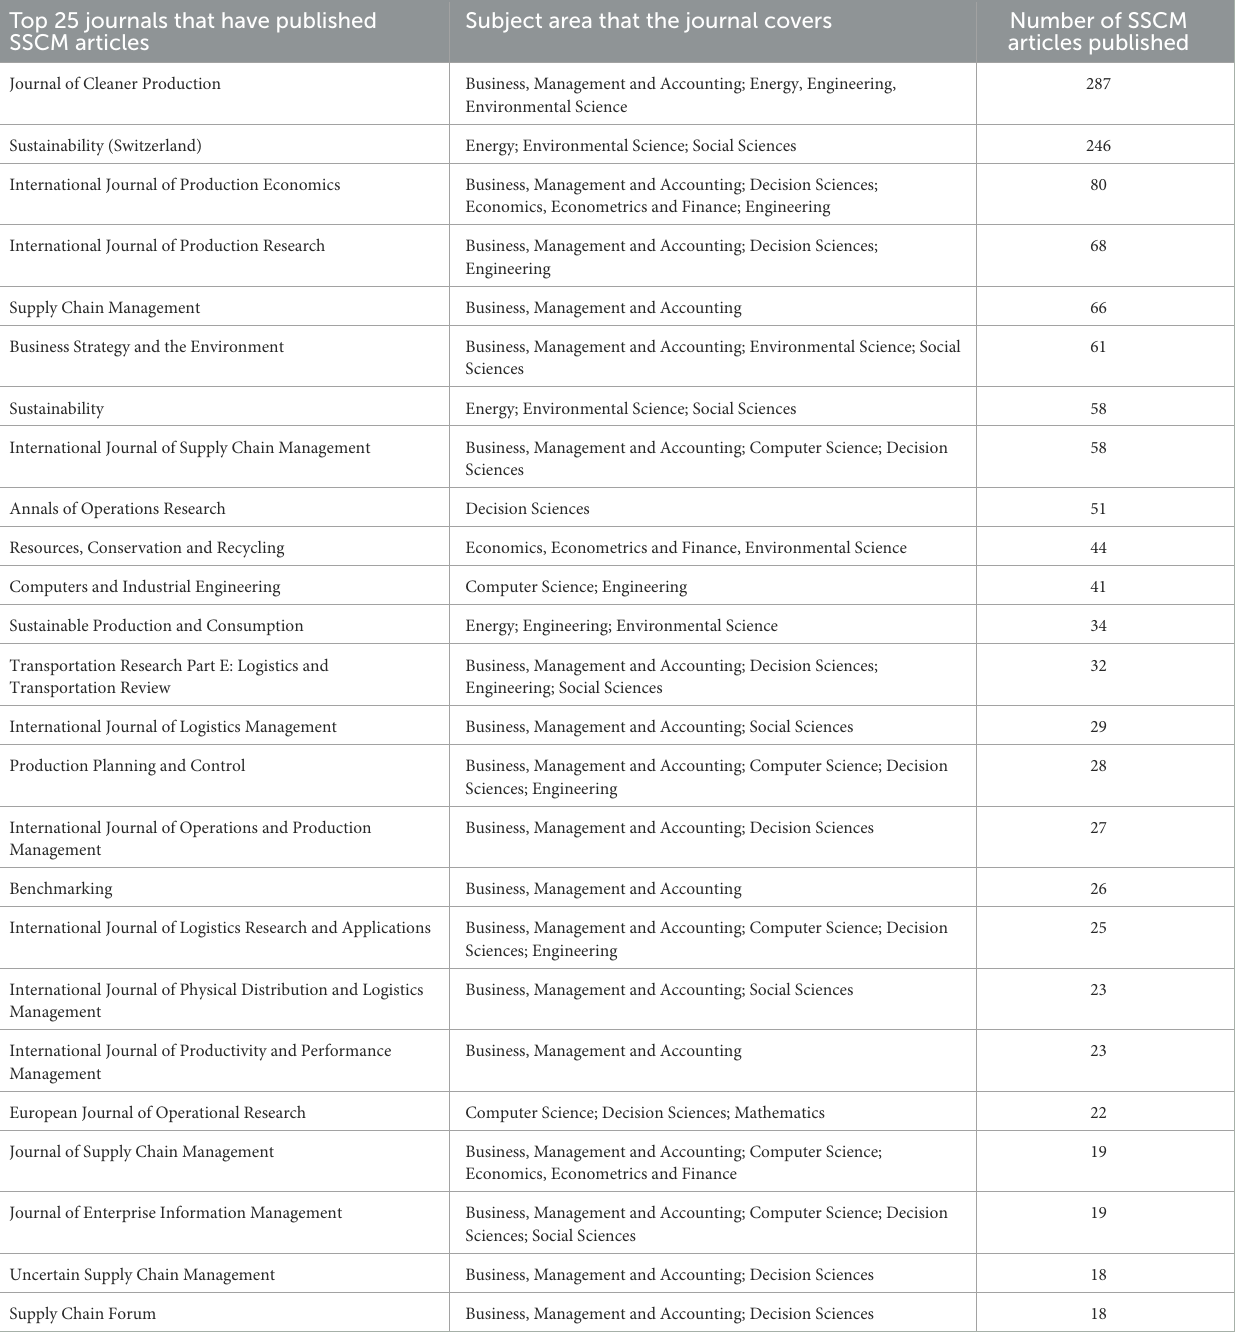
TABLE 2 Academic disciplines in top 25